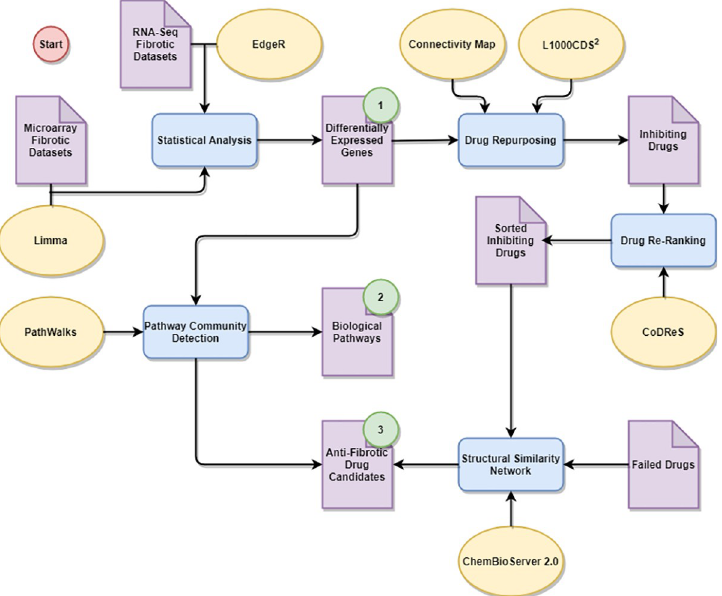
Fig 1. Flowchart of our pipeline regarding pathway analysis and drug repurposing for fibrotic diseases based on transcriptomics data. Purple pages represent data, blue rectangles represent procedures, yellow ellipses represent tools and methodologies and green circles indicate results regarding: (1) genes, (2) biological pathways and (3) inhibiting- drug candidates. We start by analyzing transcriptomics data from several tissues regarding 9 fibrotic diseases to extract key respective gene lists. We then identify common and unique perturbed biological pathways as well as potential therapeutic candidates by exploiting these gene lists.